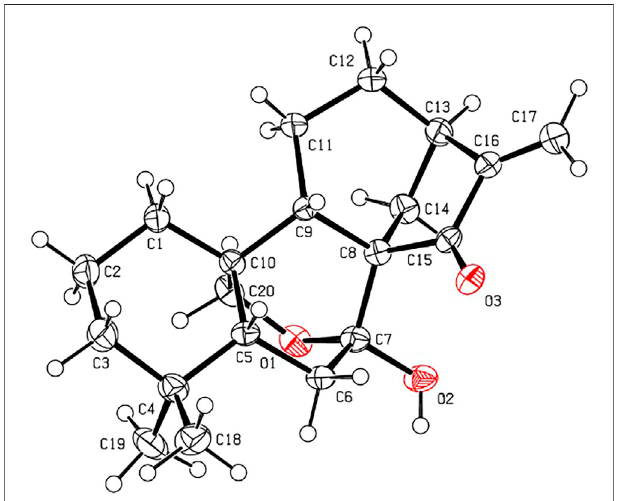
FIGURE 7 | Calculated and experimental ECD spectra for compound 4 in